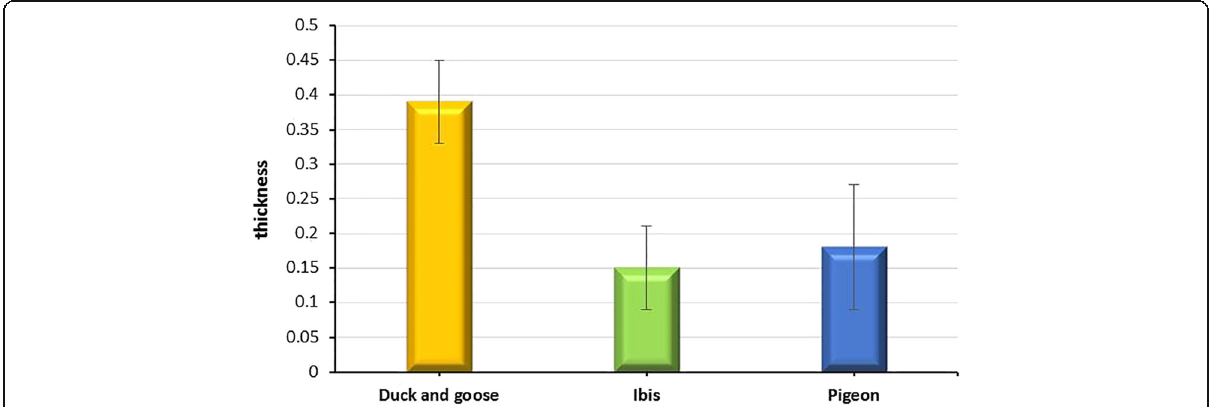
Fig. 6 Descriptive statistics of mean ± SD of thickness of HG in adult duck, goose, ibis, and pigeon